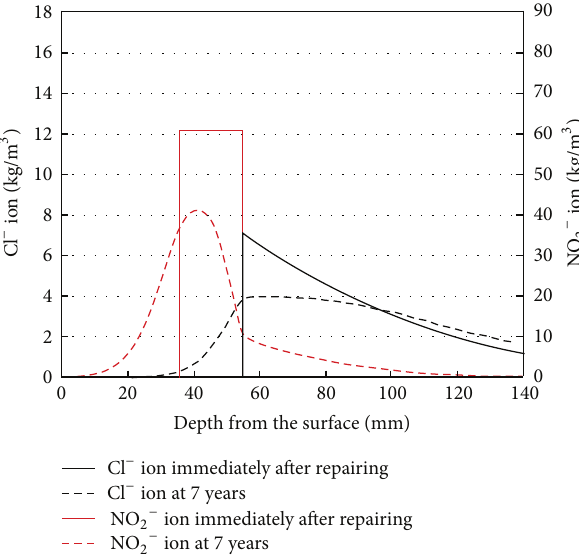
Figure 16: Cl − and NO 2− ion concentration profiles immediately after repairing and their profiles predicted up to 7